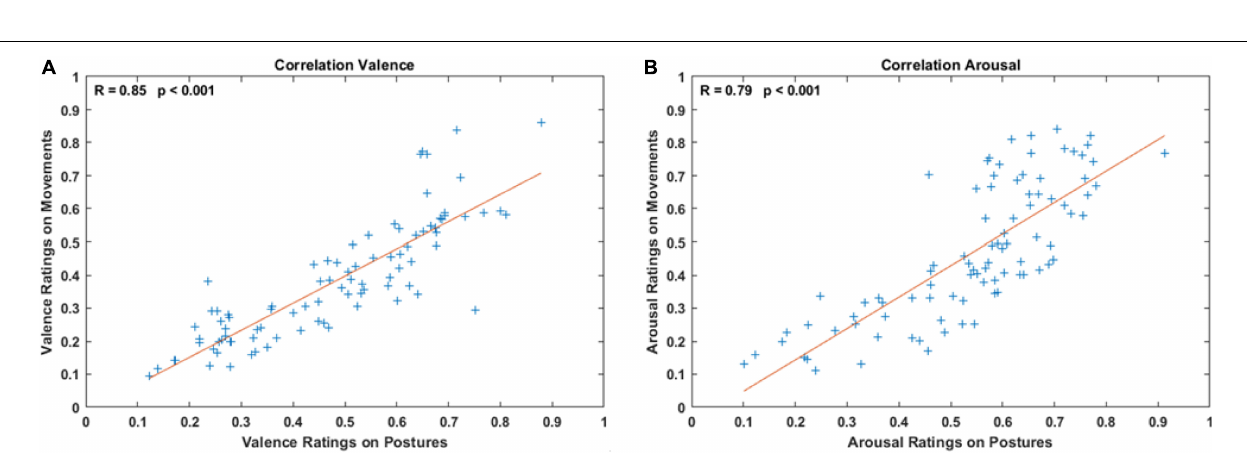
FIGURE 5 | Panels (A,B) show the correlation between valence (arousal) scores when subjects rated static postures and the corresponding walking actions. Pearson’s linear correlation coefficient and p -values are reported on the top of both panels. Red lines indicate the best linear fit between